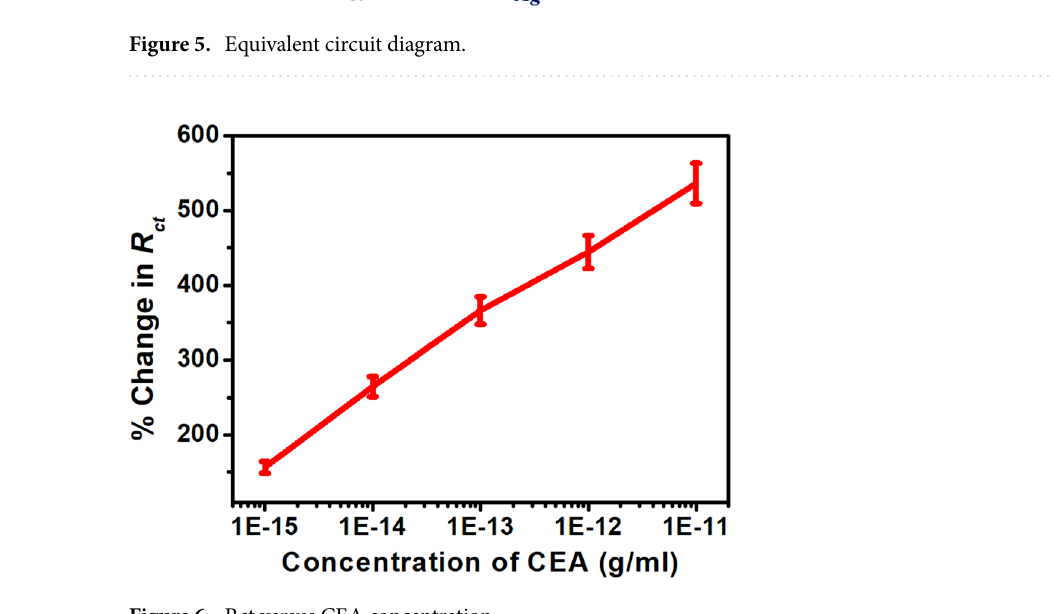
Figure 6. Rct versus CEA concentration.